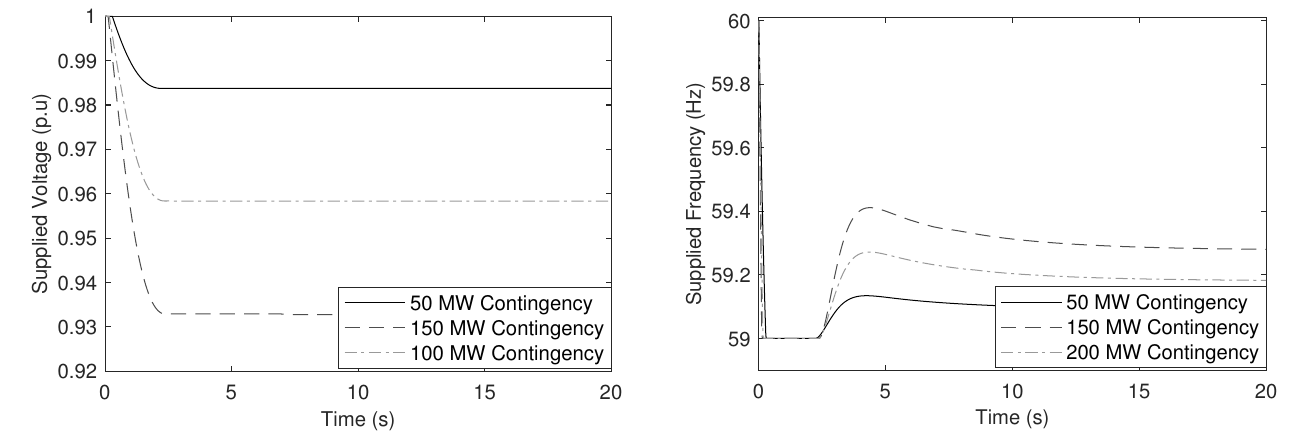
Figure 11. Supplied voltage and frequency under different levels of